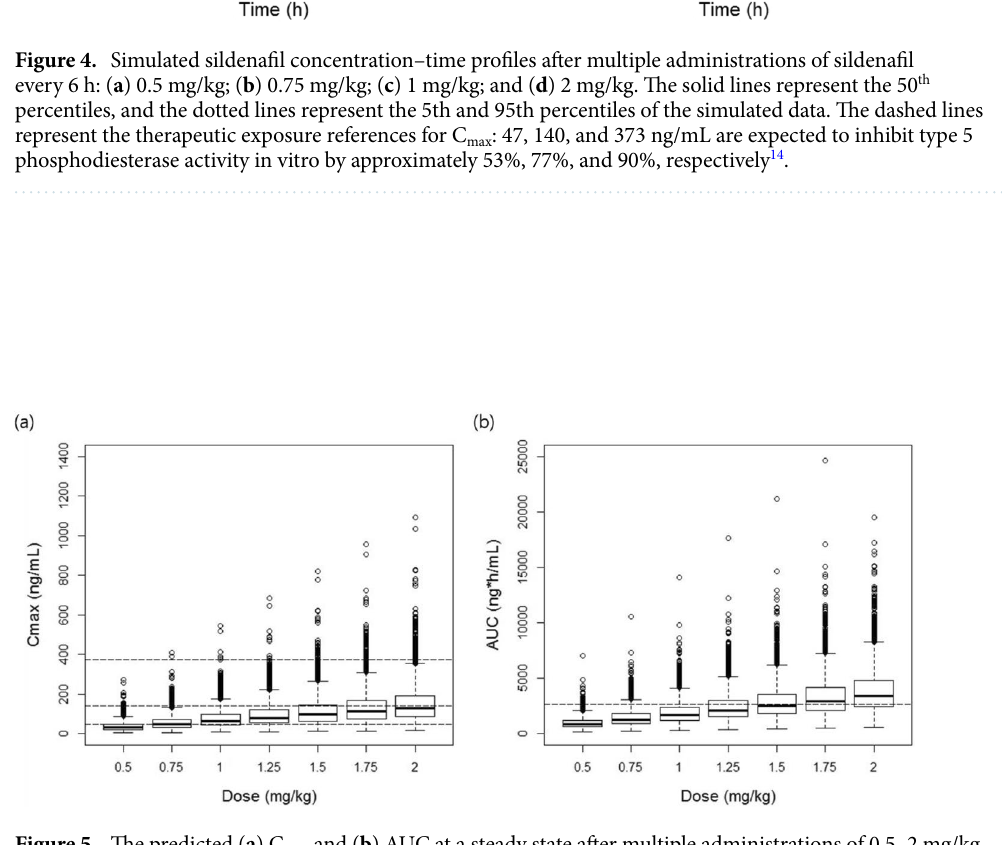
Figure 5. The predicted ( a ) C max and ( b ) AUC at a steady state after multiple administrations of 0.5–2 mg/kg of sildenafil every 6 h. The dashed lines represent the therapeutic exposure references: the C max , 47, 140, and 373 ng/mL are expected to inhibit type 5 phosphodiesterase activity in vitro by approximately 53%, 77%, and 90%, respectively 14 ; and the AUC, sildenafil and N-desmethyl sildenafil combined with an AUC > 2650 ng∙h/mL which previously showed clinical efficacy in infant patients 15